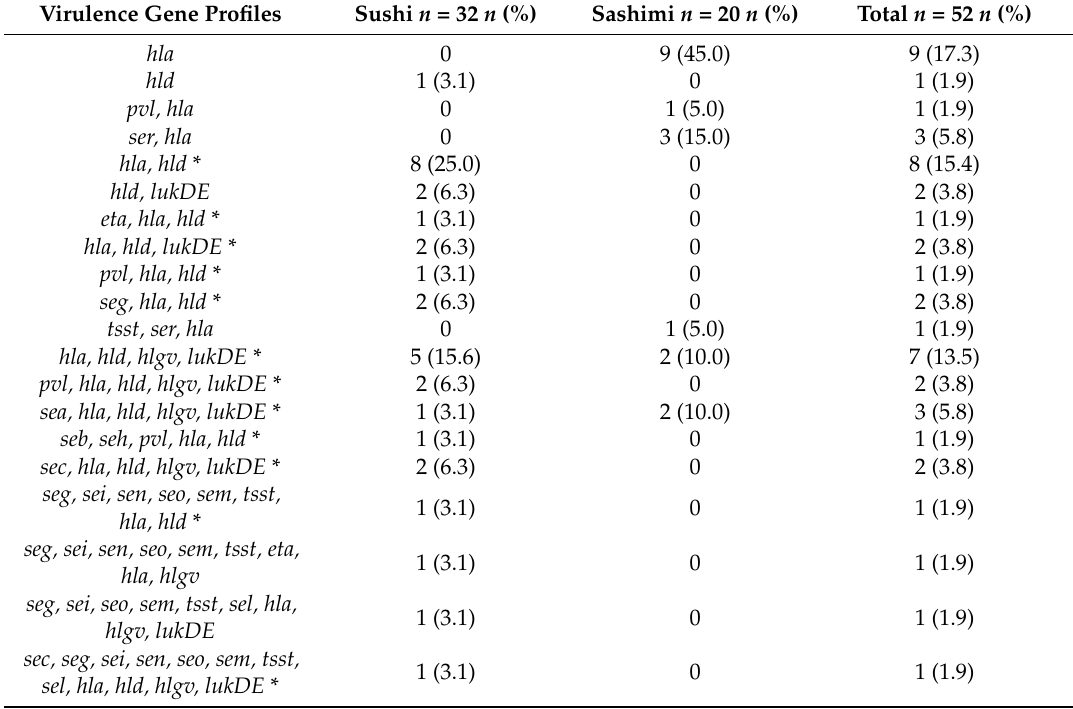
Table 2. Virulence gene profiles in 52 Staphylococcus aureus isolated from sushi and sashimi samples. Virulence Gene